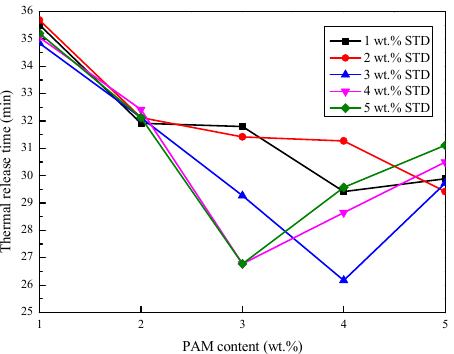
Figure 6. Effect of PAM and STD content on the thermal release time of the Na 2 SO 4 ·10H 2 O–5 wt.% KCl eutectics.